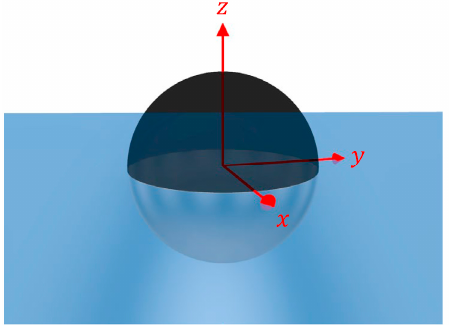
Figure 2. Fixed global coordinate system and the sphere at rest.